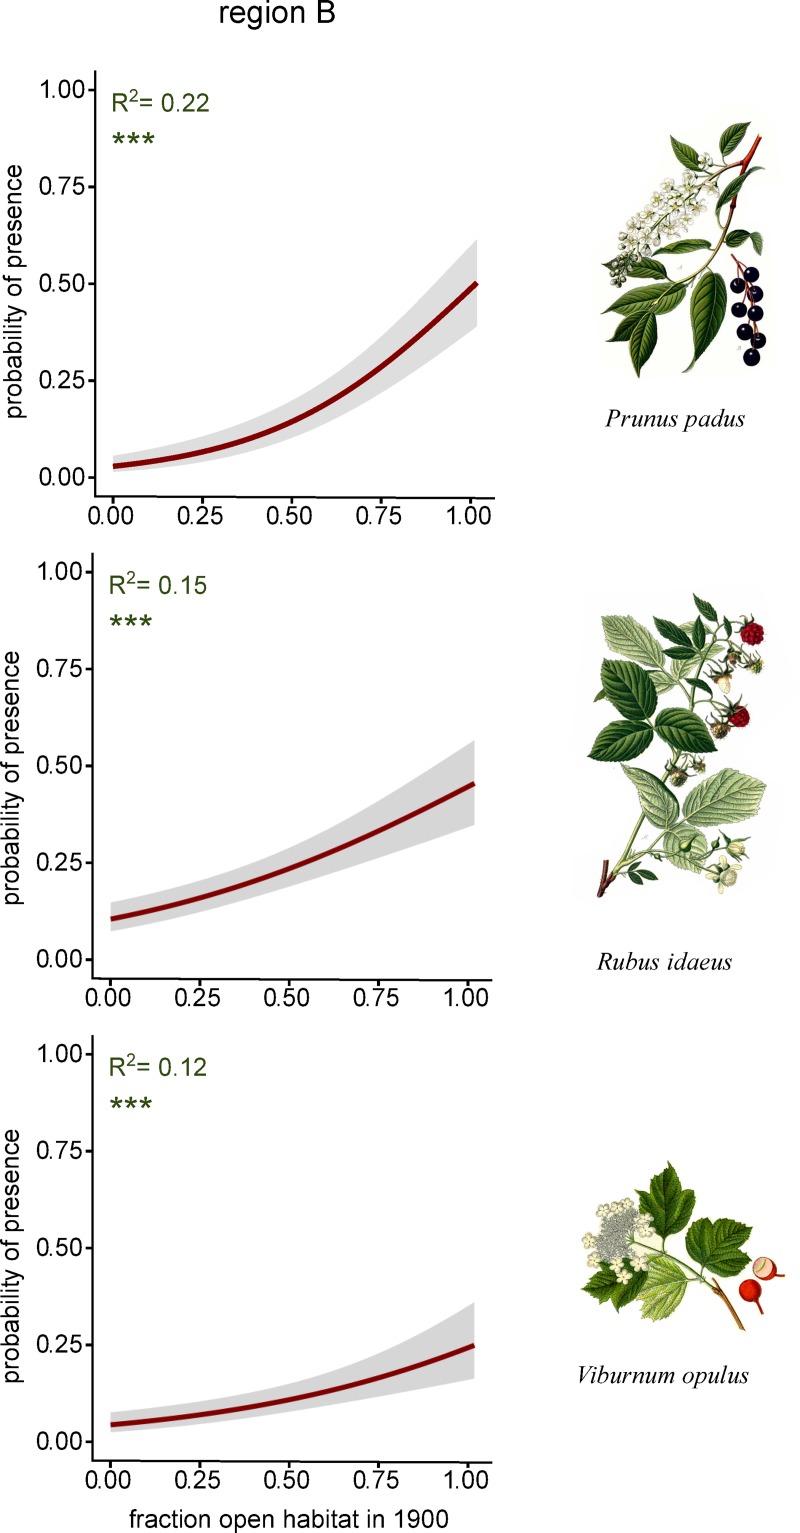
Effect of historical land use on the occurrence of fleshy-fruited woody in today’s forest.Results from testing the effect of fraction open habitat in 1900 on the occurrence of individual species in the two study regions. The predicted probabilities are based on the intercept of the fixed effect. The results are visualized for the three species where models showed the highest explanatory power. The drawings of Prunus padus and Rubus idaeus are redrawn from the Atlas des plantes de France (Masclef 1891) which is part of the public domain. The drawing of Viburnum opulus is redrawn from the Deutschlands Flora in Abbildungen (Sturm 1796) which is part of the public domain.